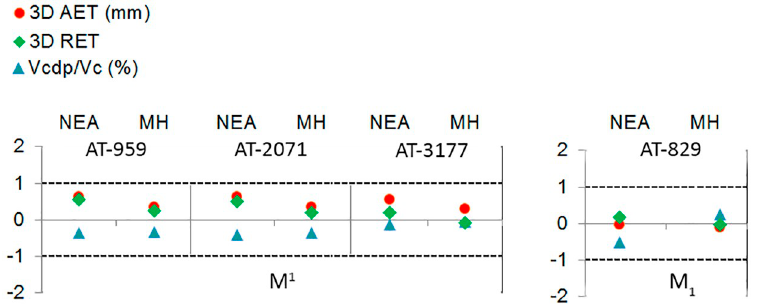
Fig 6. Adjusted Z score of the 3D variables (AET, RET and percentage of dentine). Assessed in the maxillary (specimens AT-959, AT-2071, AT-3177) and mandibular (specimen AT-829) molars from SH and compared to the variation expressed by Neanderthals (blue triangles) and modern humans (red circles). The solid line passing through zero represents the mean, and the other two lines correspond to the estimated 95% limit of variation expressed for the two comparative samples.